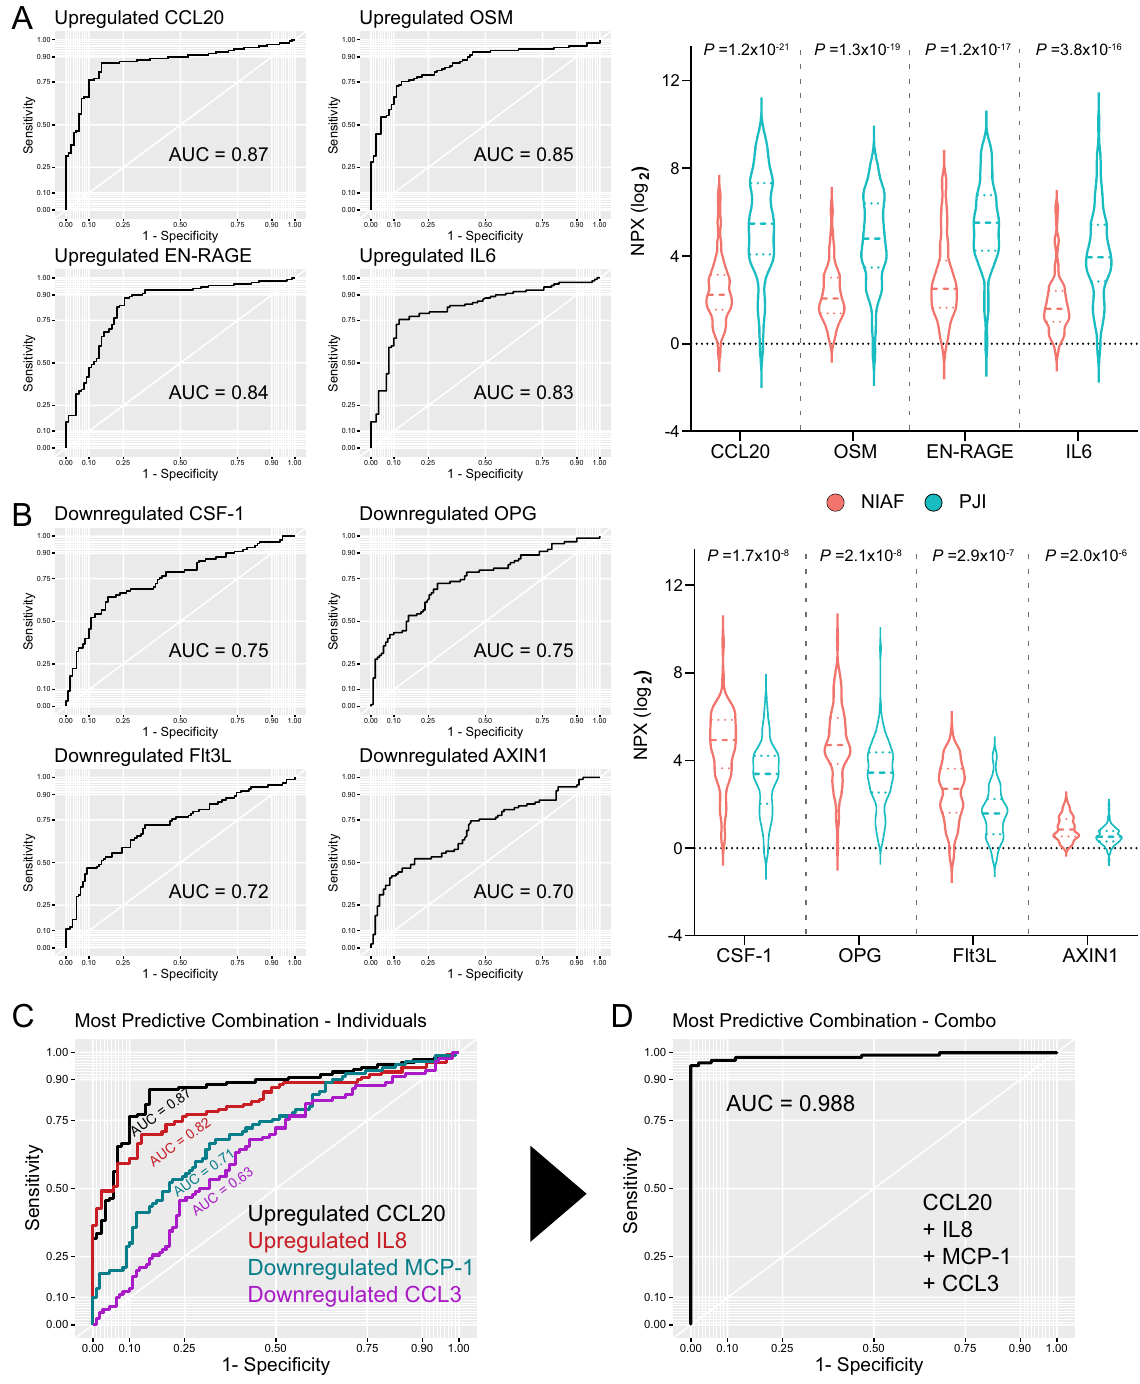
Figure 2. Top predictive proteins differentiating periprosthetic joint infection (PJI) from non-infectious arthroplasty failure (NIAF) identified in sonicate fluid using the Olink Proteomics - Inflammation Panel. Receiver operative characteristic (ROC) curves, including area under the curve (AUC), and normalized protein expression (NPX) counts, including associated adjusted P -values, of the top four ( A ) upregulated and ( B ) downregulated proteins in PJI compared to NIAF are shown. ROC curves showing the most differentially predictive combination of protein targets, including ( C ) individual and ( D ) combined protein target analyses. Statistical significance was determined via Welch’s 2-sample t-test, with Benjamini–Hochberg multiple comparison adjustment. Data depicted are for NIAF (n = 90) and PJI (n = 110) sonicate fluid